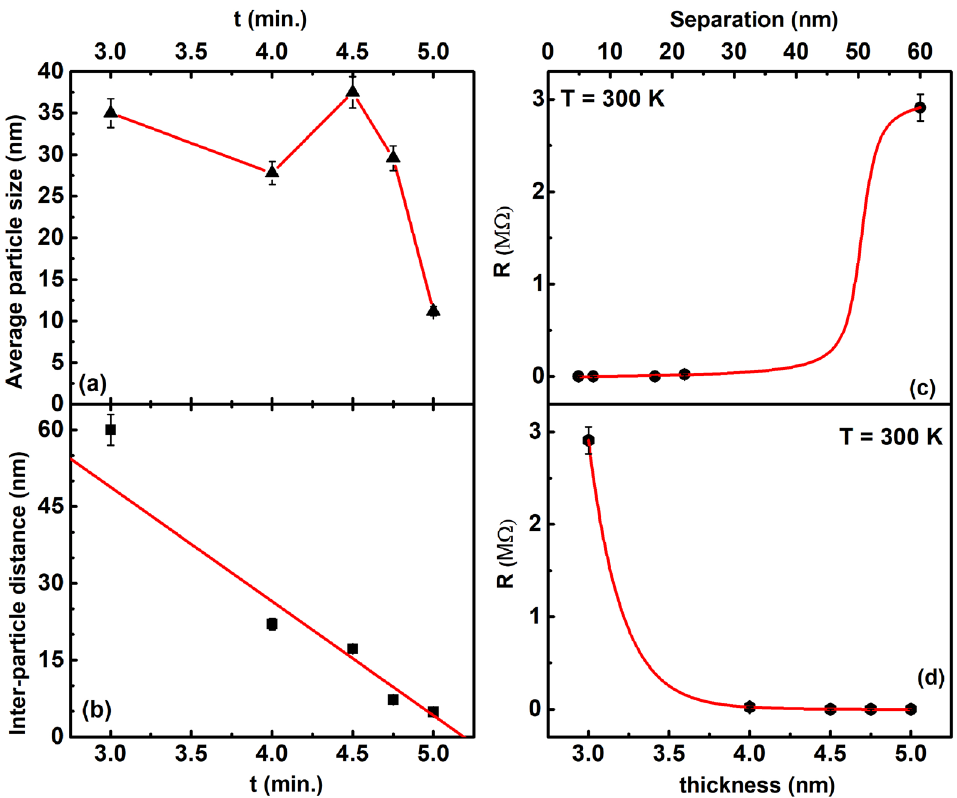
Figure 4. ( a ) Variation of average particle size with time (in minutes). Filled black triangles represent the average particle-size obtained from the log-normal fits to the AFM data of Fig. 3. Red solid curve is a guide to the eye. ( b ) Filled black squares correspond to the inter-particle separation obtained from the AFM images of Fig. (3). Red solid curve is a straight line fit to the data. From the fit, the slope m was obtained as 22.3 and the intercept c as 115.7. ( c ) Filled circles represent room temperature resistance variation with inter-island separation of films made by varying the deposition time. Red solid curve is a fit to the Langevin’s function (see text for details). ( d ) Filled hexagons correspond to thickness variation of resistance measured at room temperature in ultra-thin films of Pd. Red solid curve is a fit to Eq.